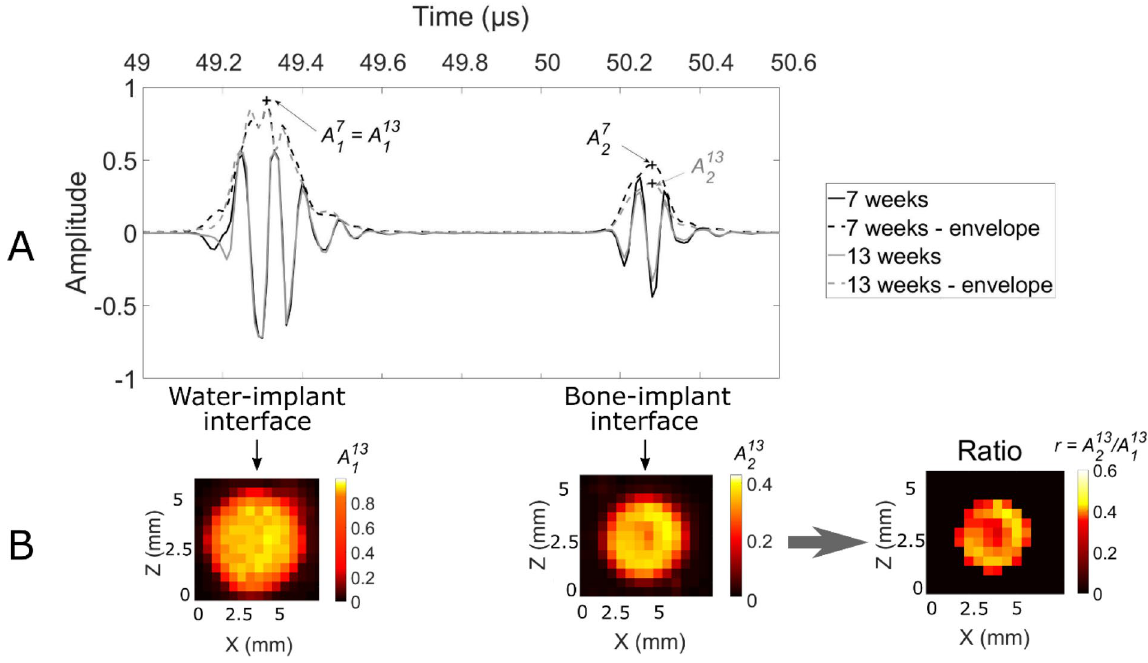
Figure 3. ( A ) Typical radiofrequency signals obtained for rough implants inserted for 7 (black line) and 13 weeks (grey line) and their corresponding envelopes in dashed lines. The lower script x in A x corresponds to the interface: 1 for water-implant and 2 for implant-bone. The upper script y in A y corresponds to the number of weeks of healing time. ( B ) 2D maps corresponding to the spatial variations of A 1 , A 2 and r for a 13 week osseointegrated sample, ratios r = A 2 / A 1 are shown only for positions for which A 2 >